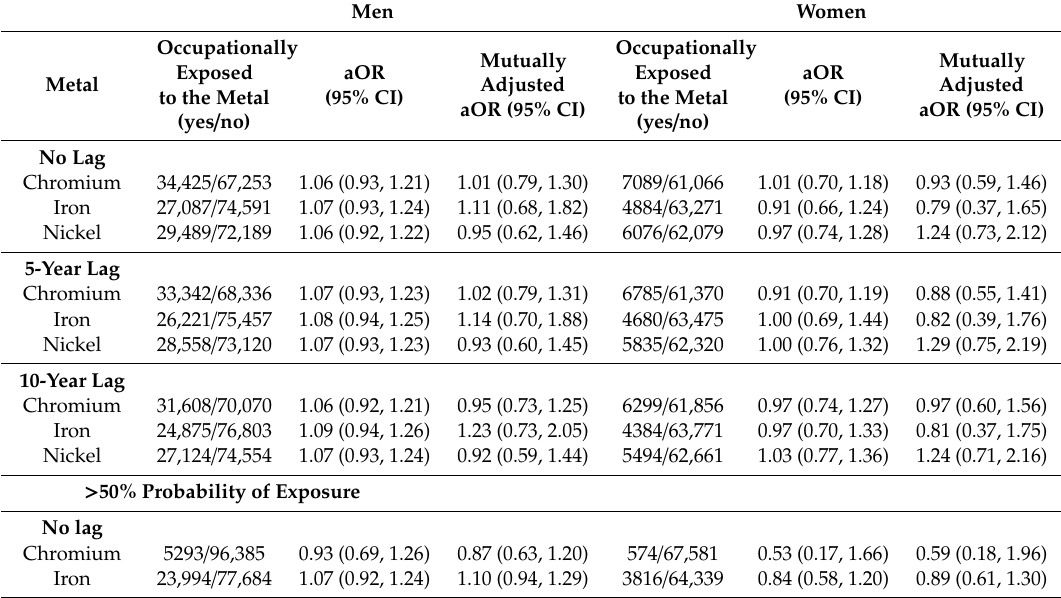
Table 2. Odds of ALS based on logistic regression, Denmark,